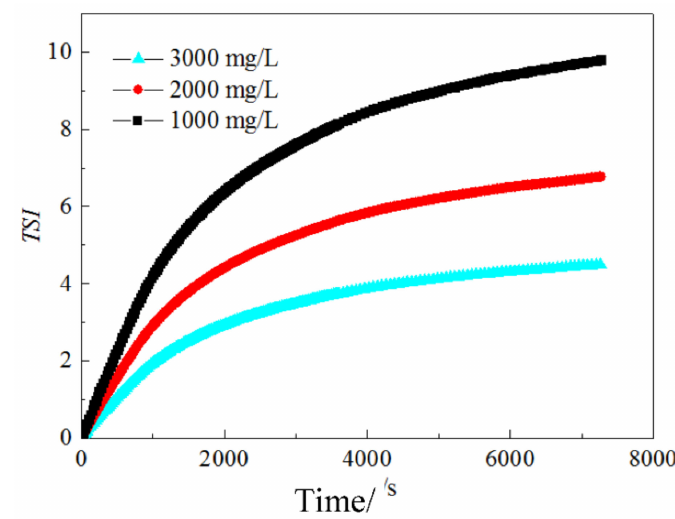
Figure 10. Relationship between the TSI value and the surfactant concentration.